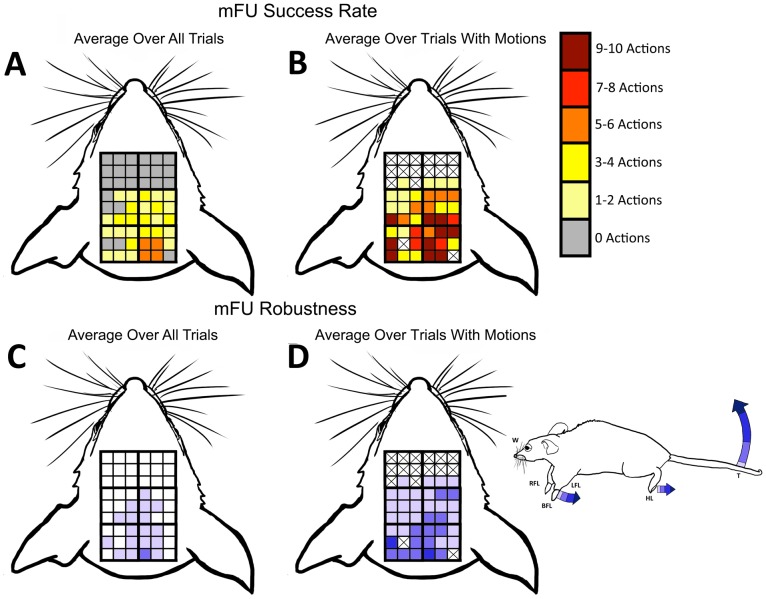
Metrics for successful stimulation by mFU.Measures of robustness and success rate of induced motions by mFU averaged over 5 mice. The X’s in (B) and (D) indicate that no movement in those regions was ever observed. X’s are not shown in (A) or (C) because there is the possibility that the data rounded down to 0 (<0.5 actions).